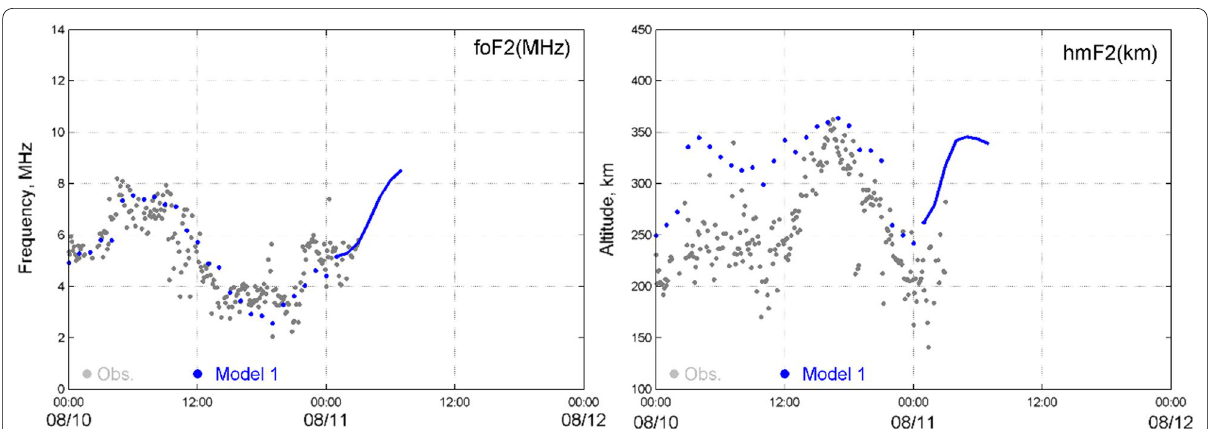
Fig. 15 Comparisons between assimilated results together with their 6‑h forecasts of foF2 and NmF2 and those observed by a local ionosonde in Taiwan during 10–11 August